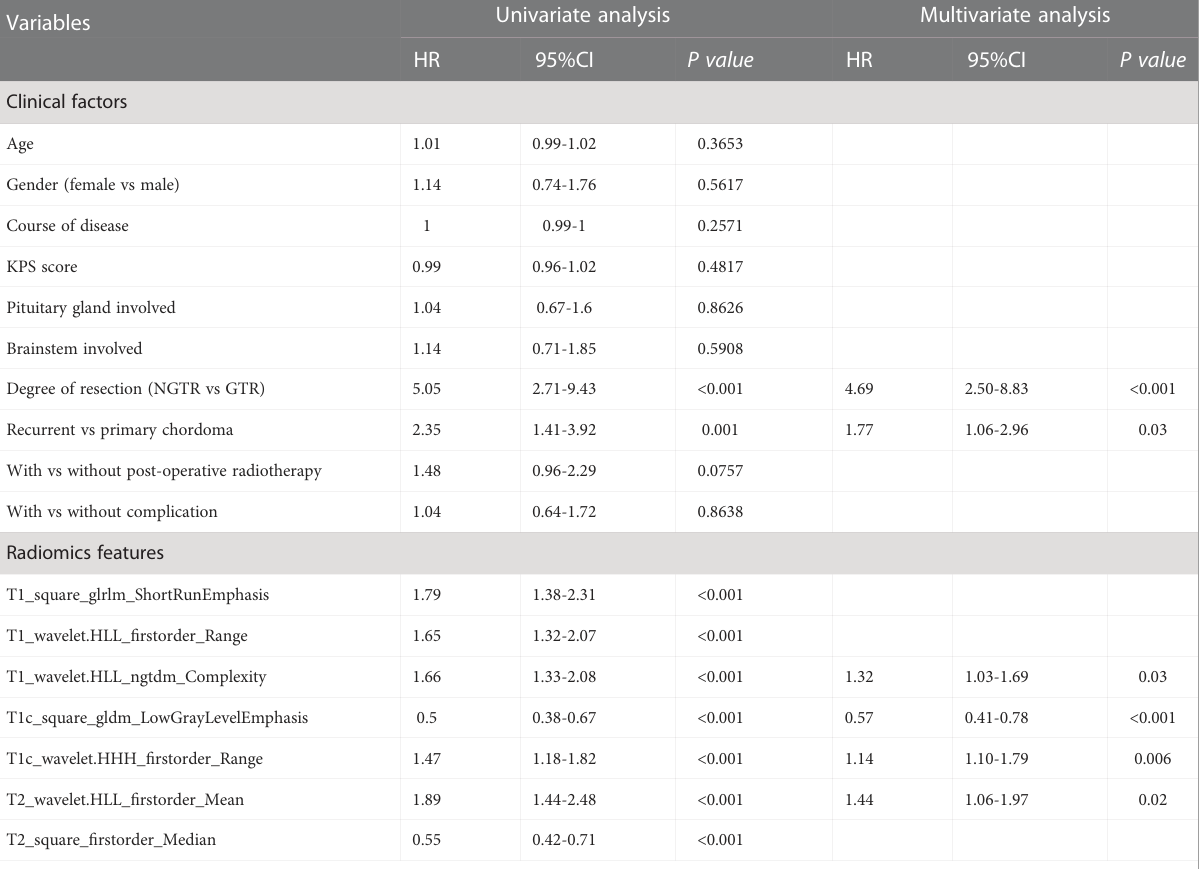
TABLE 2 Univariate and multivariate Cox regression analysis.